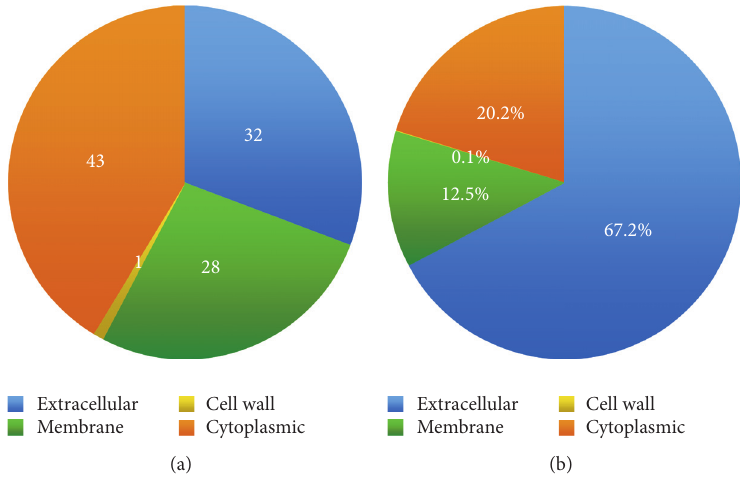
Figure 4: Subcellular localization of proteins identified in Streptococcus pneumoniae BAA-255 extracellular membrane vesicles (EMVs). The subcellular localization of the different proteins identified in the EMVs according to the number of proteins (a) or the total amount of protein (b) is shown. The subcellular localization of the proteins was determined by using CELLO